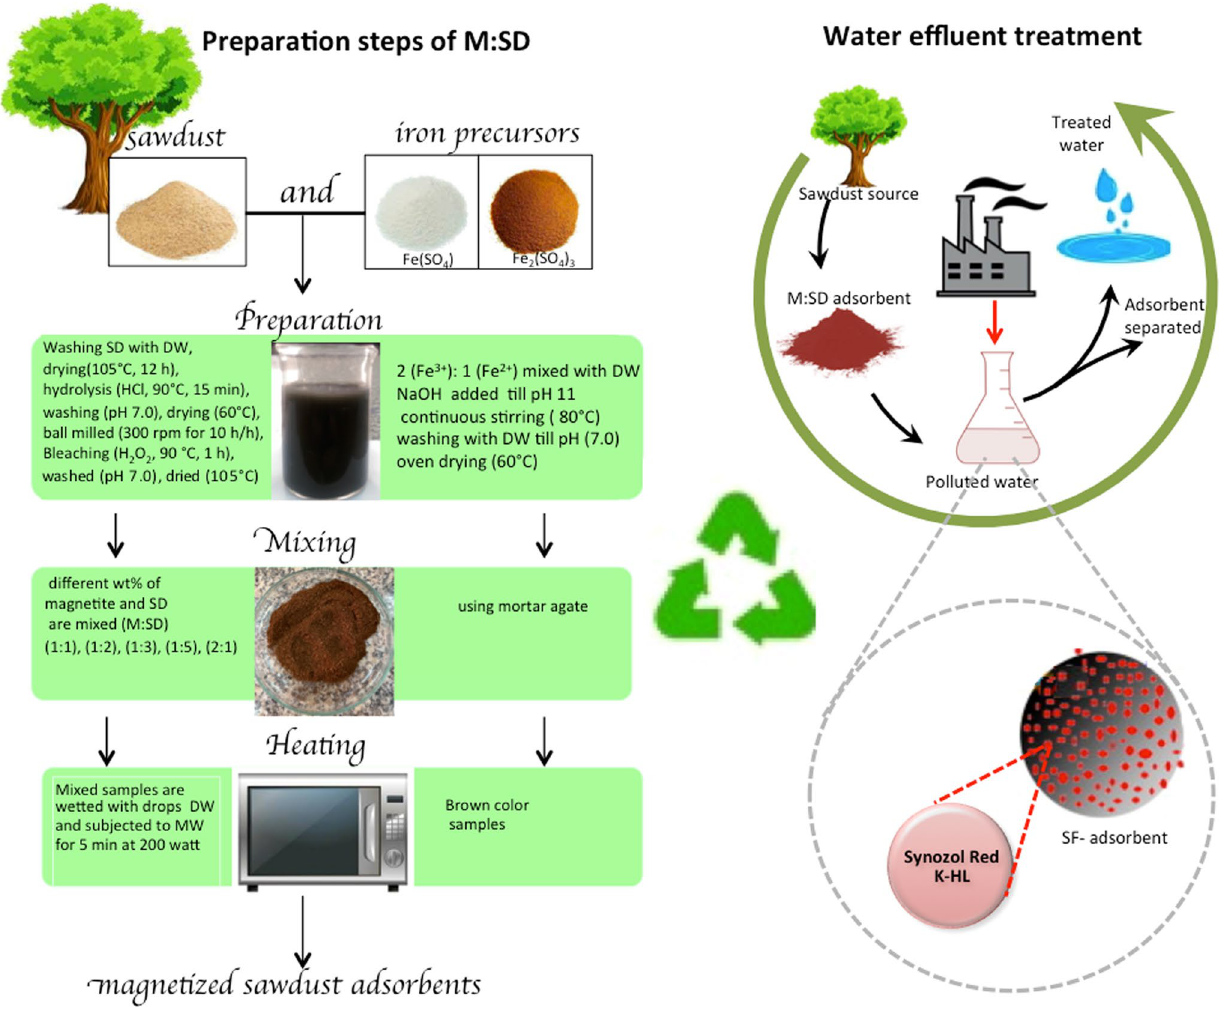
Fig. 1 Schematic showing preparation procedure of magnetized sawdust for wastewater treatment “adsorption”